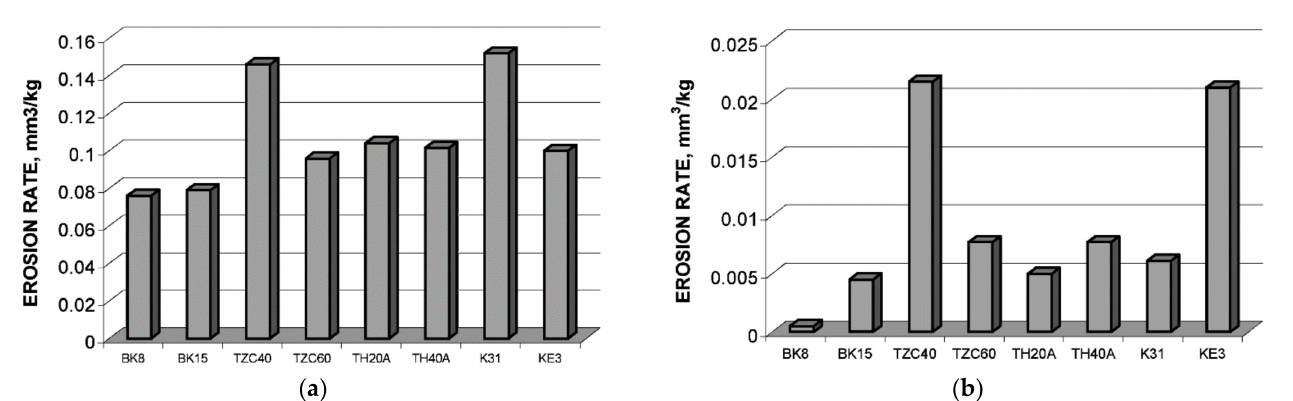
Figure 9. Steady state erosion rates of ceramic–metal composites: abrasives ( a ) SiC (0.1–0.3 mm) and ( b ) SiO 2 (0.1–0.3 mm). Erosion conditions: jet velocity 61 m/s, impact angle α = 75 ◦ . Materials: TZC40, TZC60 (TiC-40 and 60 wt% FeCrSi, respectively); TH20A, TH40A (TiC-20 and 40 NiMo (Ni:Mo ratio 2:1), respectively); K31, KE3 (Cr 3 C 2 -15 and 30 wt% Ni, respectively); BK8, BK15 (WC-8 and 15 wt% Co, respectively) [83].